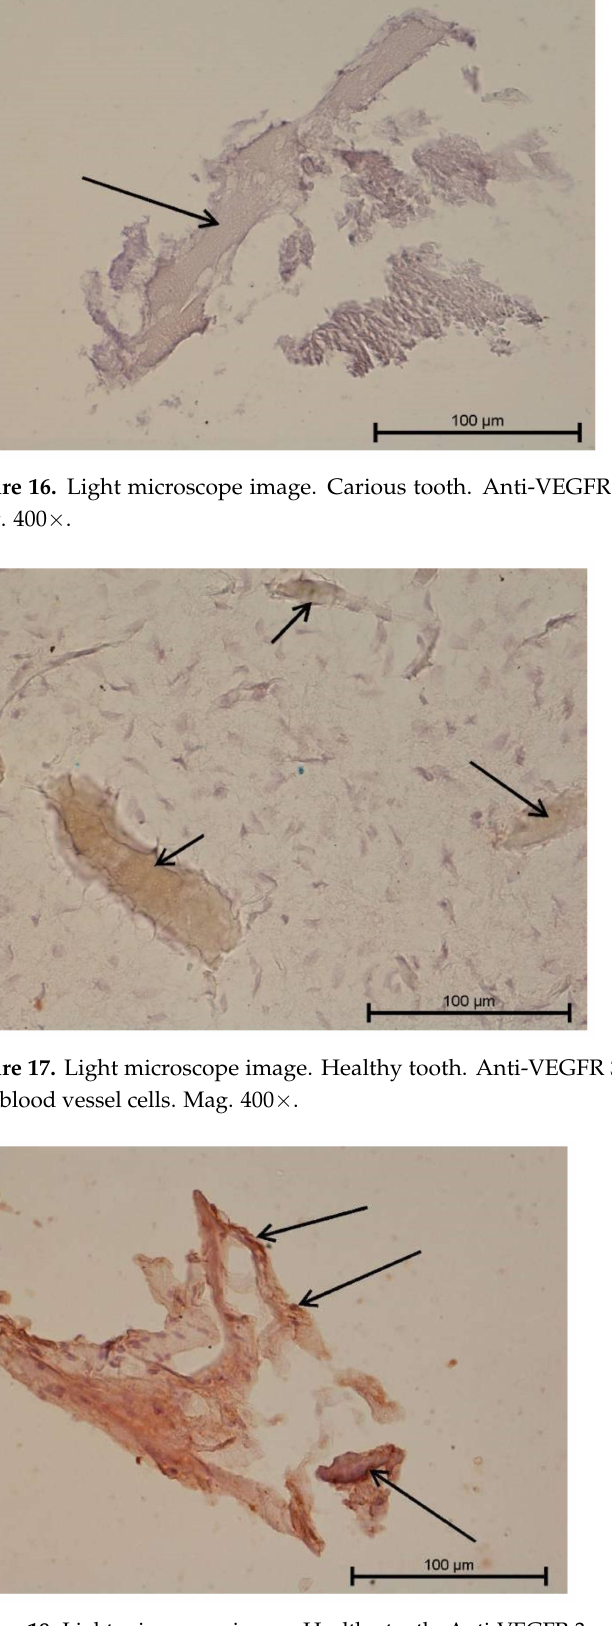
Figure 18. Light microscope image. Healthy tooth. Anti-VEGFR 3—positive (black arrow). Mag. 400 ×